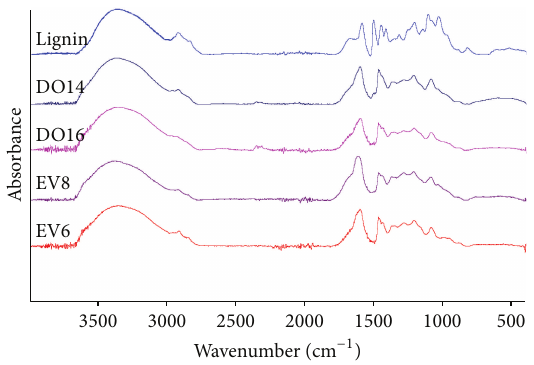
Figure 11: Lignin and some organic xerogels FTIR.